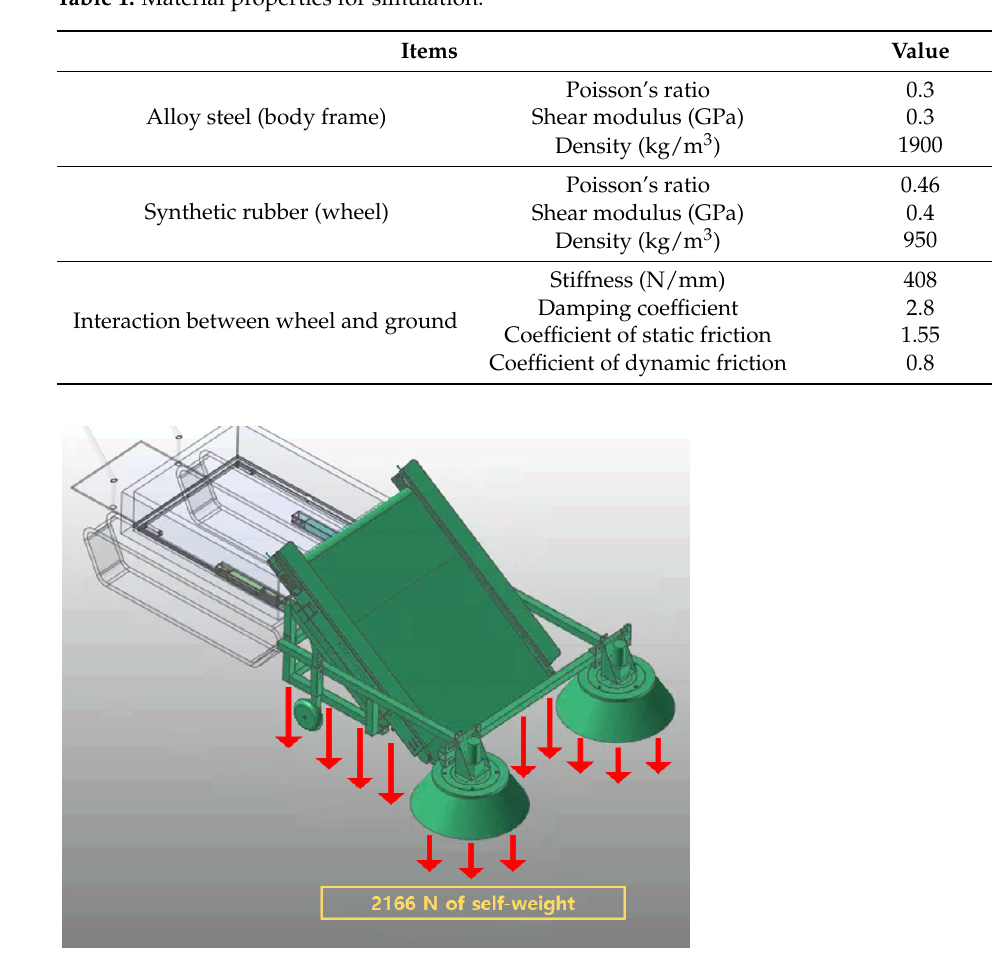
Figure 4. Self-weight of collecting/transferring part.